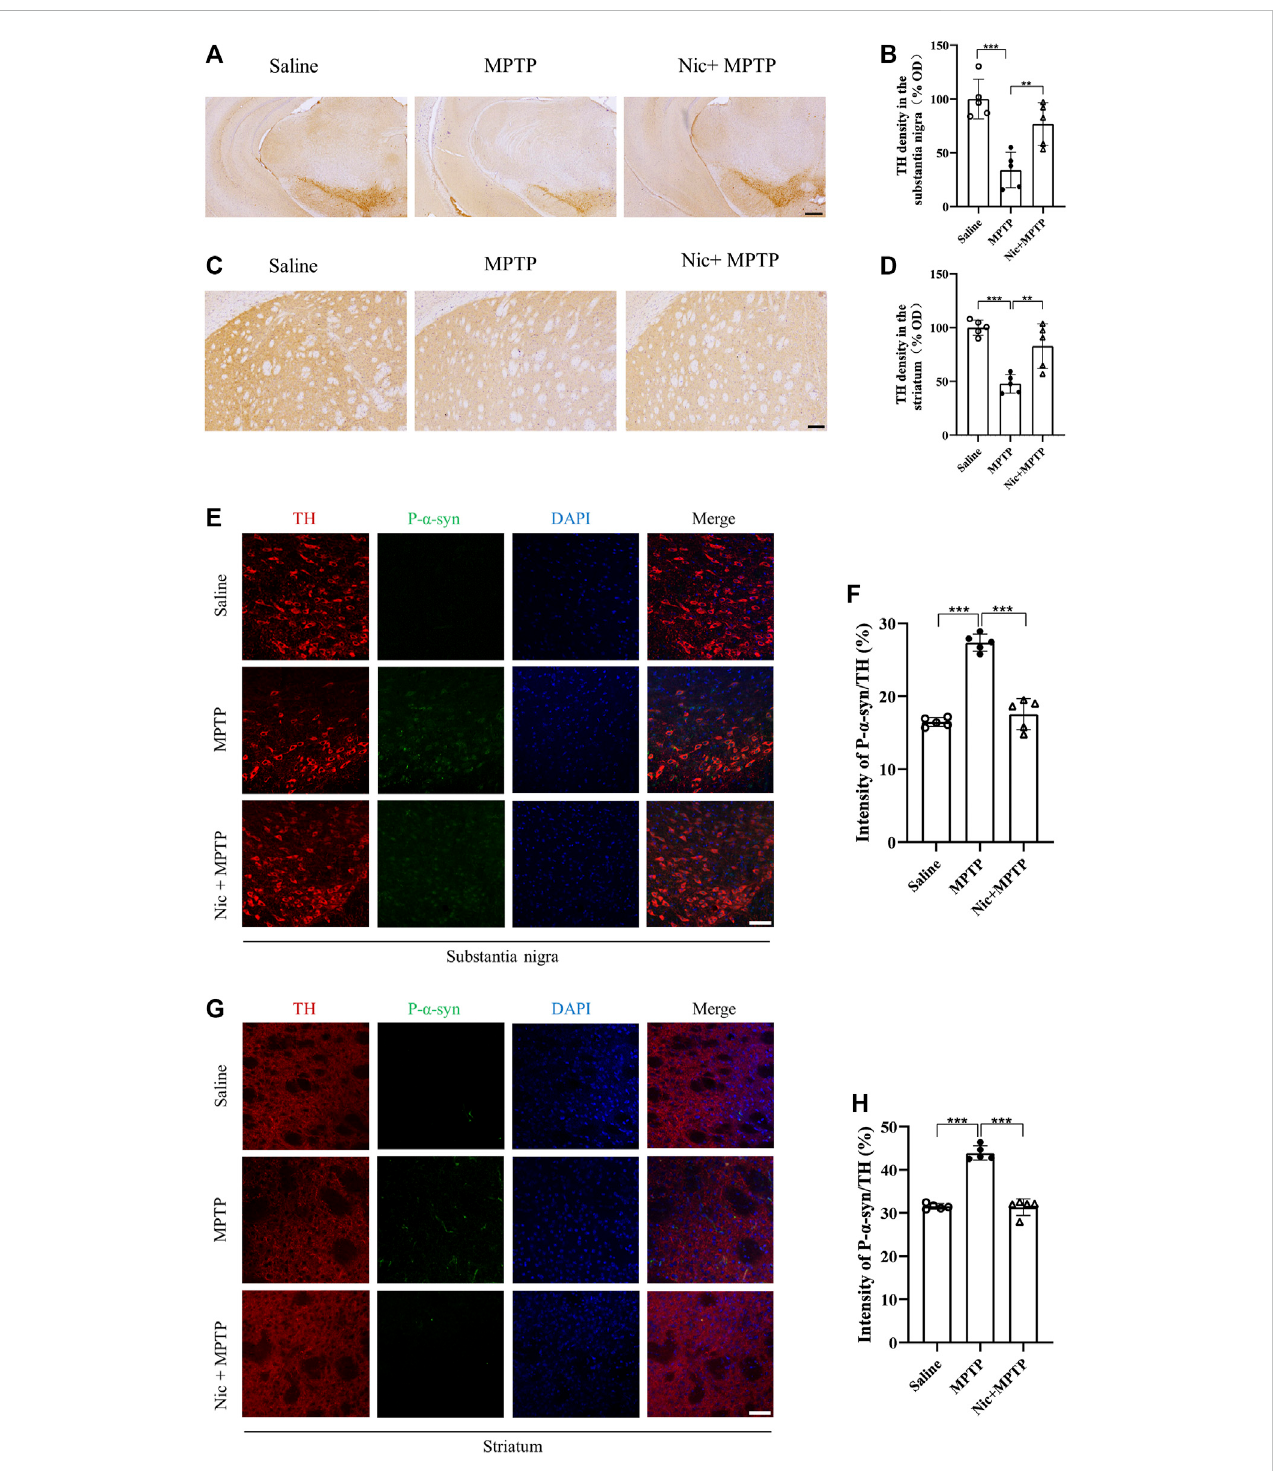
FIGURE 3 Effects of nicotine on dopaminergic neurons and p- α -syn expression in the substantia nigra and striatal brain regions of MPTP-treated mice. (A) Immunohistochemical staining results of TH-positive neurons in the midbrain. Scale bar at 300 μ m. (B) Statistical map of TH-positive neurons density. (C) Immunohistochemical staining results of TH expression in striatal regions. Scale bar at 100 μ m. (D) Statistical map of TH expression density. (E) Immuno fl uorescence histochemical staining results of tissue sections in the substantia nigra. Scale bar at 100 μ m. (F) Statistical results of p- α -syn fl uorescence intensity to TH ratio in the substantia nigra. (G) Immuno fl uorescence histochemical staining results of the striatal tissue sections. Scale bar at 100 μ m. (H) Statistical results of p- α -syn fl uorescence intensity to TH ratio in the striatal regions. Data are expressed as mean ± SEM from fi ve mice in each group, every point on the graph is an average from four fi xed fi elds of view for each mouse. Signi fi cant differences were determined by an unpaired Student ’ s t-test and one-way ANOVA followed by Tukey ’ s multiple comparison post hoc test. * p < 0.05, ** p < 0.01, *** p <